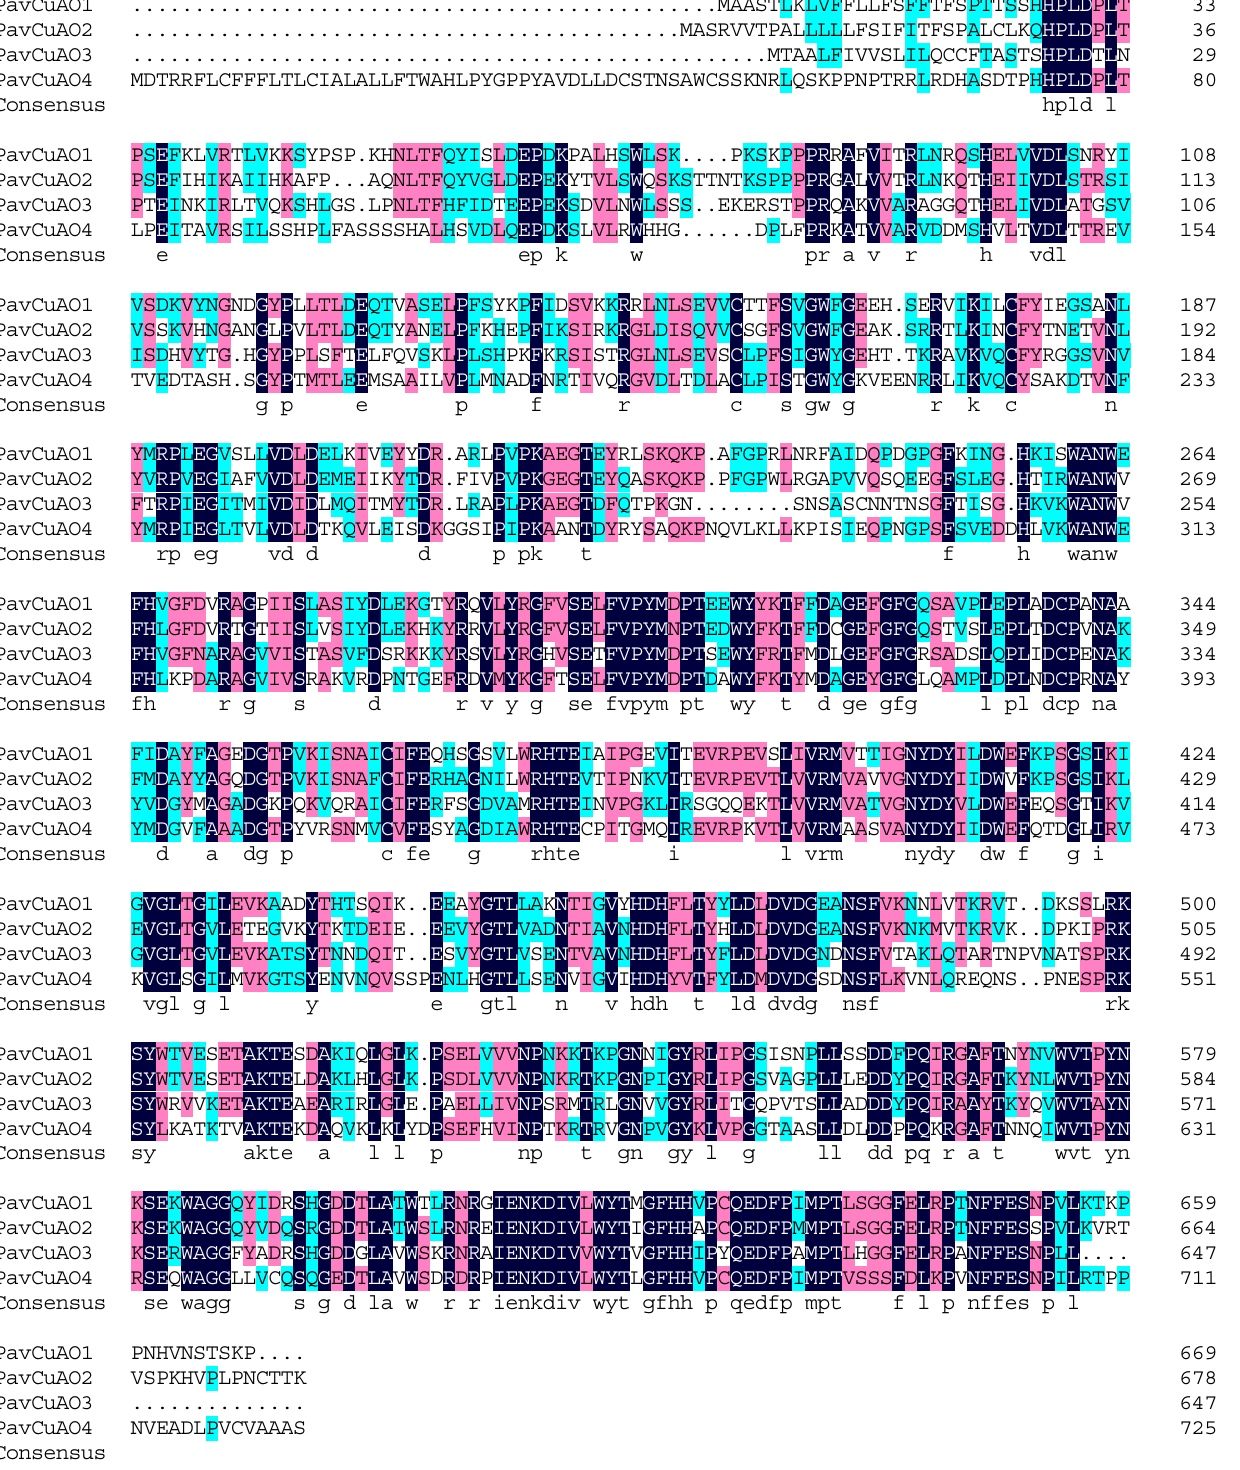
Figure 3. Amino acid sequence comparison of PavCuAO genes. (Black, red, and blue backgrounds indicate 100%, 75%, and 50% amino acid sequence similarity, respectively).